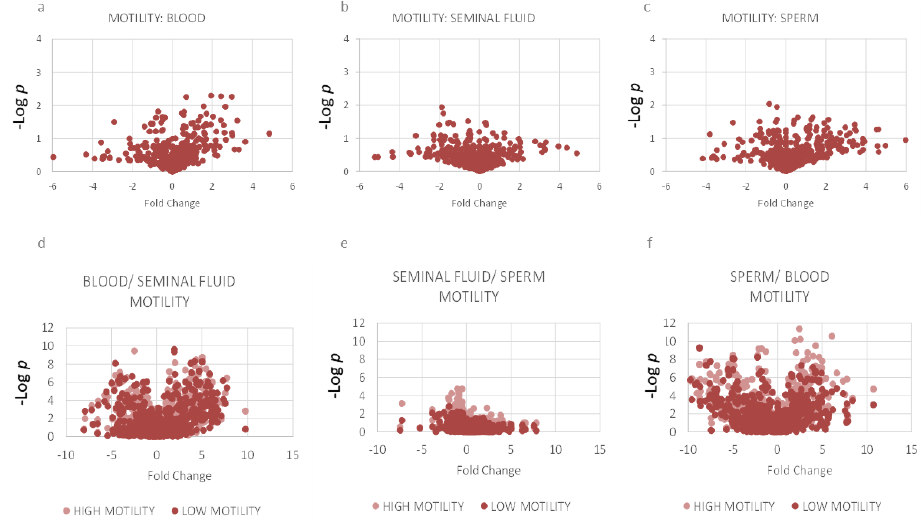
Figure 2. Significant differences in individual lipid species in comparing higher vs. lower motility in each compartment ( a – c ) and between compartments ( d – f ) shown on volcano plots. Lipid metab- olites were tested for significance (-log p ) and fold change between low motility and high motility groups within each compartment ( a – c ; using unpaired t tests) and between compartments ( d – f ; us- ing paired t tests) in order to demonstrate differences.